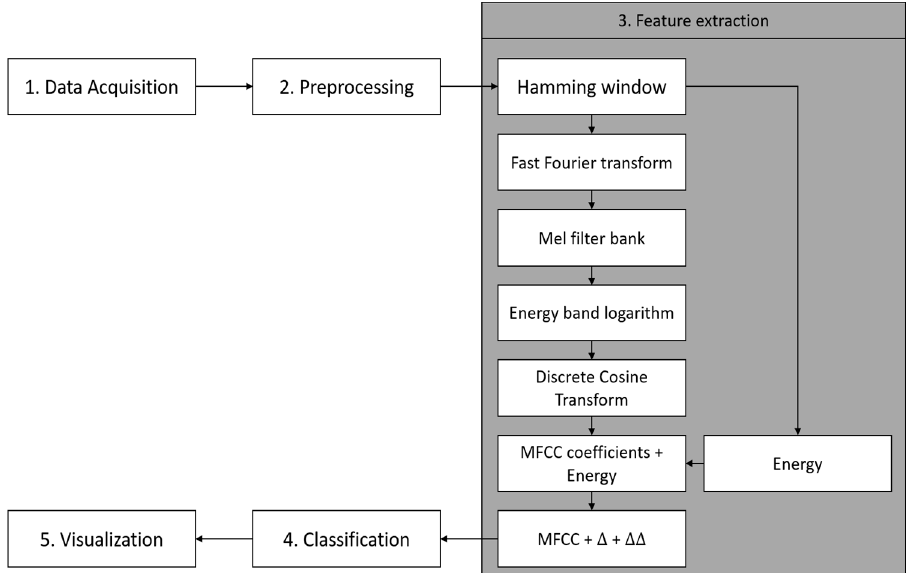
Figure 12. A proposed step for MFCC feature extraction.